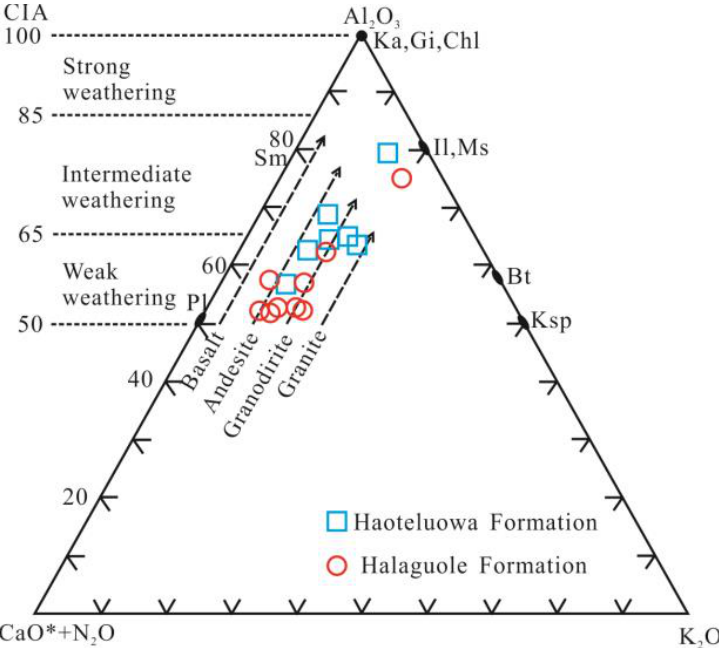
Figure 7. A–CN–K triangular diagram of sandstones for the Carboniferous sandstones in Alake Lake, EKO (after Nesbitt and Young [50,57]; Fedo et al. [51]). Data for tonalite (To), granodiorite (Gd), granite (Gr), and average post-Archean upper crust are from Condie [55]. Abbreviations for